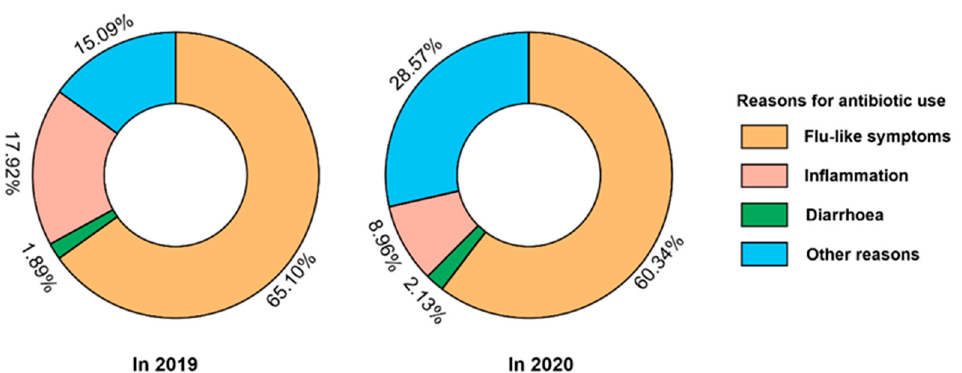
Figure 2. Sources of antibiotics in medicine diaries among the study population in Eastern China, 2019–2020. (Data shown are unstandardized percentages. In total, the sources of antibiotics changed significantly after COVID-19 ( p = 0.002)).